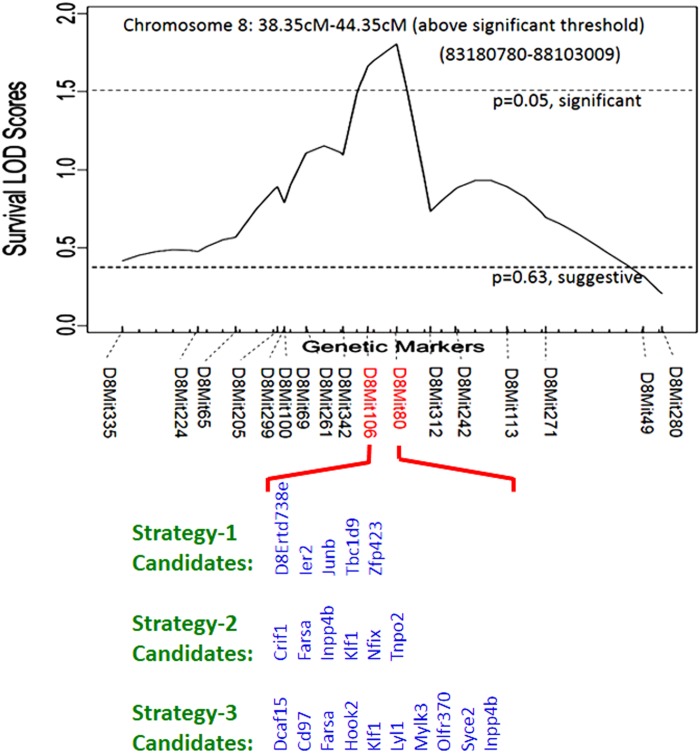
Chromosome substitution strain 8 (CSS8) mice were susceptible to S. aureus infection and QTL mapping found a region with putative candidate genes on chromosome 8.Chromosome 8 LOD score plot for susceptibility to S. aureus in N2 backcross mice (F1 [C8A] × C57BL/6J). A total of 337 intercross mice (both sexes; age 6 to 8 weeks) were injected via intraperitoneal route with 107 CFU/g S. aureus Sanger 476 and observed every 8 hours continuously for 5 days. Thresholds for significant (p = 0.05) and suggestive (p = 0.63) linkage are indicated by the horizontal dashed lines. LOD score was determined by the J/qtl permutation test using 1,000 permuted data sets. The microsatellite markers for determining genotypes of N2 backcross mice are marked along the X-axis.